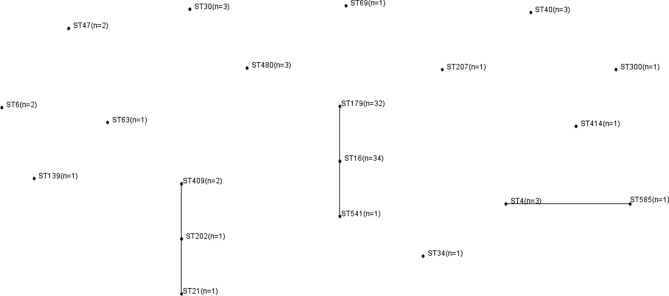
Distribution of MLST and clonal complex (CC) among 98 E. faecalis isolates. Connecting lines indicate CCs.